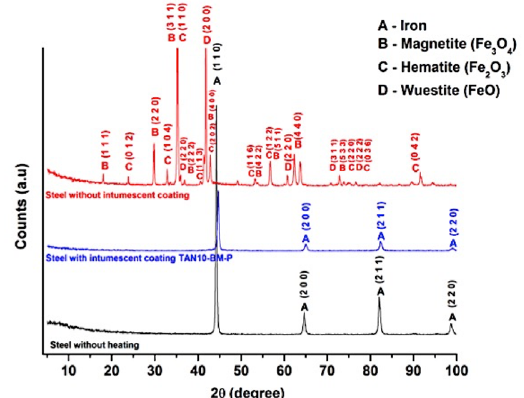
Figure 8. X-ray diffraction patterns of the steel substrates after fire